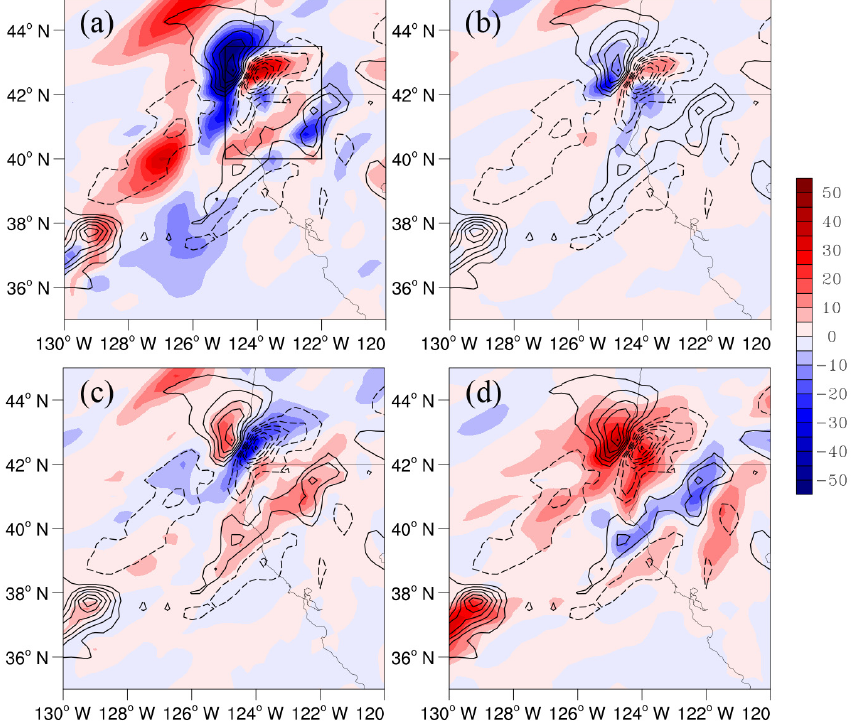
Figure 7. Horizontal distributions of the energetics (shadings; in 10 − 4 m 2 s − 3 ) and mesoscale vertical velocity ( − ω ∼ 2 ; contours; in Pa/s) averaged vertically from 900 to 300 hPa on 25 February at 10:00 UTC: ( a ) Γ 0 → 2 , ( b ) Γ 1 → 2 , ( c ) Γ 0 → 2 and ( d ) − b 2 . The box in ( a ) denotes the rainfall area during Stage I. Solid contours represent the ascending motion with an interval of 0.2.